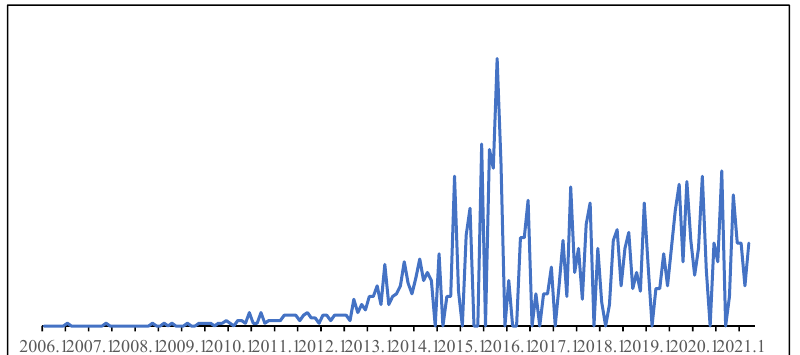
Smart Cities 2021 , 4, FOR PEER REVIEW Figure 2. China’s smart city search trend from 2006 to 2021 (data source: Google trend).